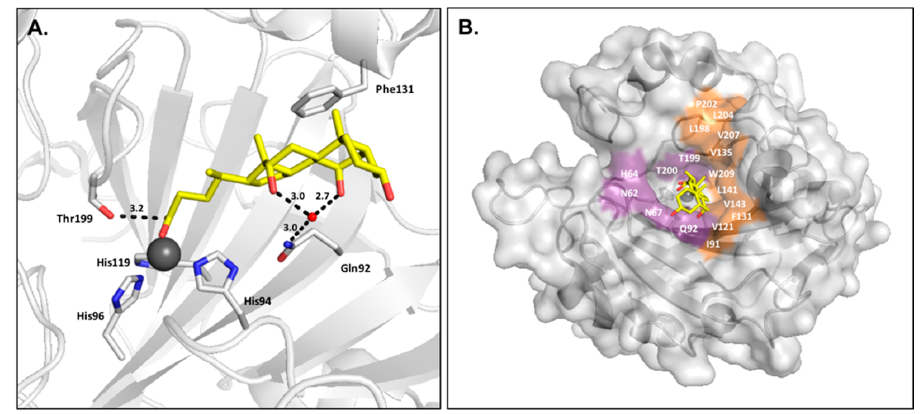
Figure 5. ( A ) CA ΙΙ ( gray ) in complex with cholic acid ( yellow ) (PDB:4PXX); ( B ) Surface representation of CA II in complex with cholic acid ( yellow ). of CA II in complex with cholic acid ( yellow